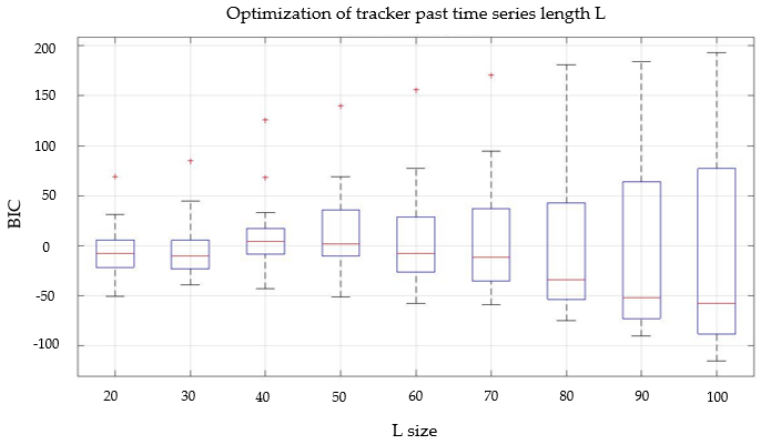
Figure 9. Optimization stage for tracker segment length L . Values from 20 to 100, with a shift of 10 between two attempts, have been tested. L = 40 is selected since it maximizes BIC. Each value is repeated g = 25 times and the statistical distribution of corresponding results is provided in the associated box plot.